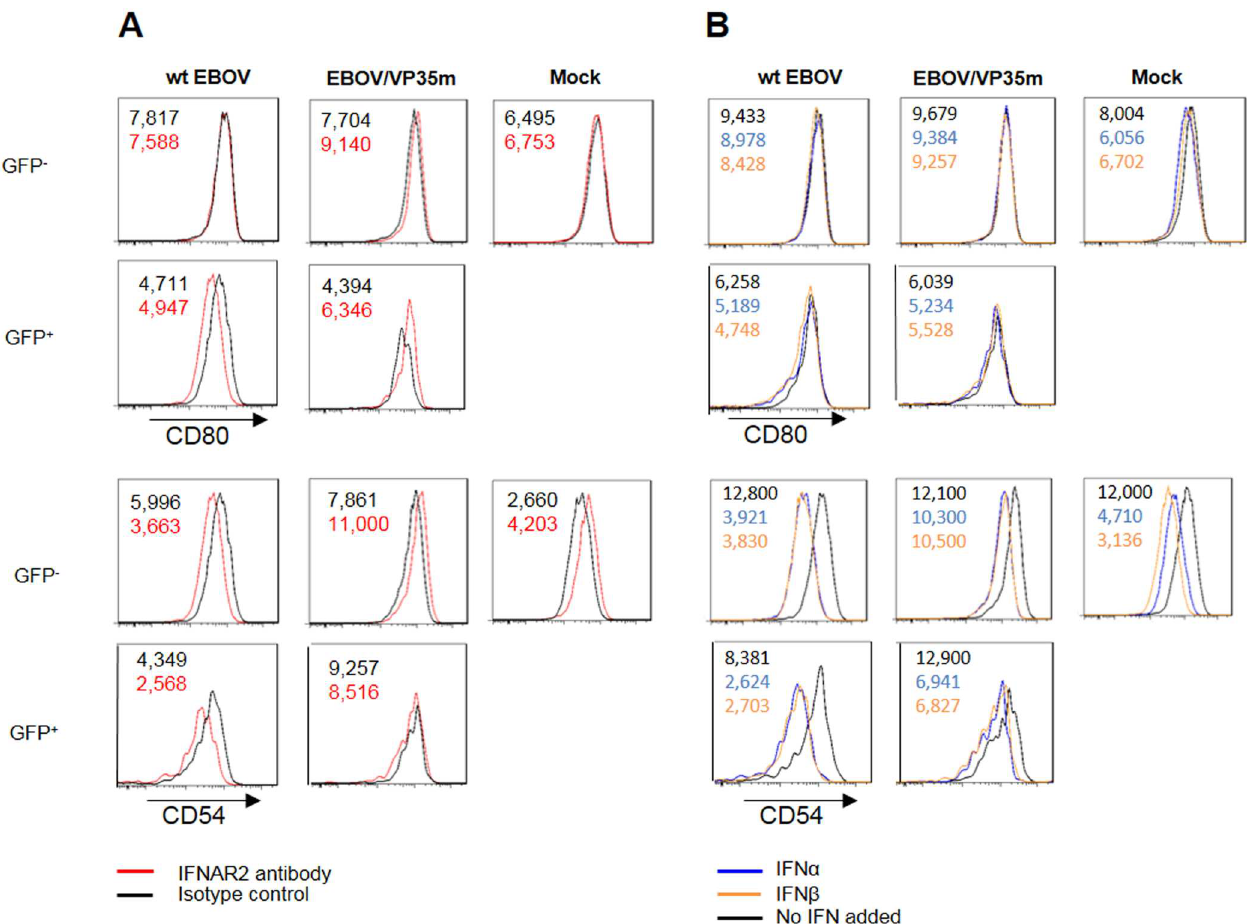
Fig 5. Suppression of IFN-I signaling and the prevention of IFN-I releaseby EBOV play only a limited role in inhibition of DC maturation. A. Effect of IFNAR2 blockadeon expressionof CD86. B. Effect of exogenously added IFN α and IFN β on expressionof CD86. Mean fluorescent intensity (MFI) for CD86 + mock-treated DC (black), or DC treated with IFNAR2 antibodies,IFN α , or IFN β (colors) are indicatedin the top left corners. The experiment was performed two times with different donors, with essentiallysimilar